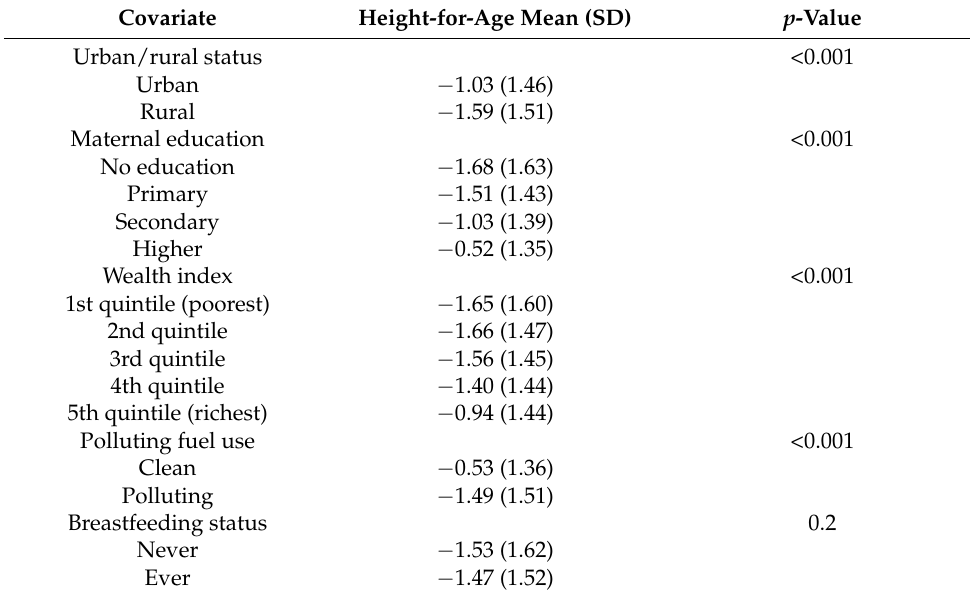
Table 3. Results from bivariate analyses of each covariate’s association with height-for-age.